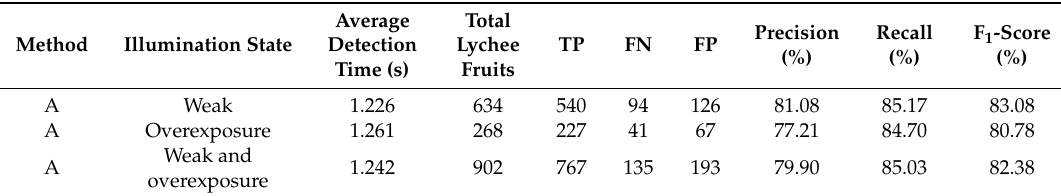
Figure 12. Results of isolated and lychee fruit cluster detection performance under overexposure and weakly illuminated conditions without using the LBP-SVM classifier. ( A,B ) Foreground segment results without using image preprocessing. ( C,D ) Foreground segment results using image preprocessing. ( E,F ) Results of lychee fruit detection using Method A. Table 3. Detection results of overlapped lychees under weak or overexposure illumination without using the LBP-SVM